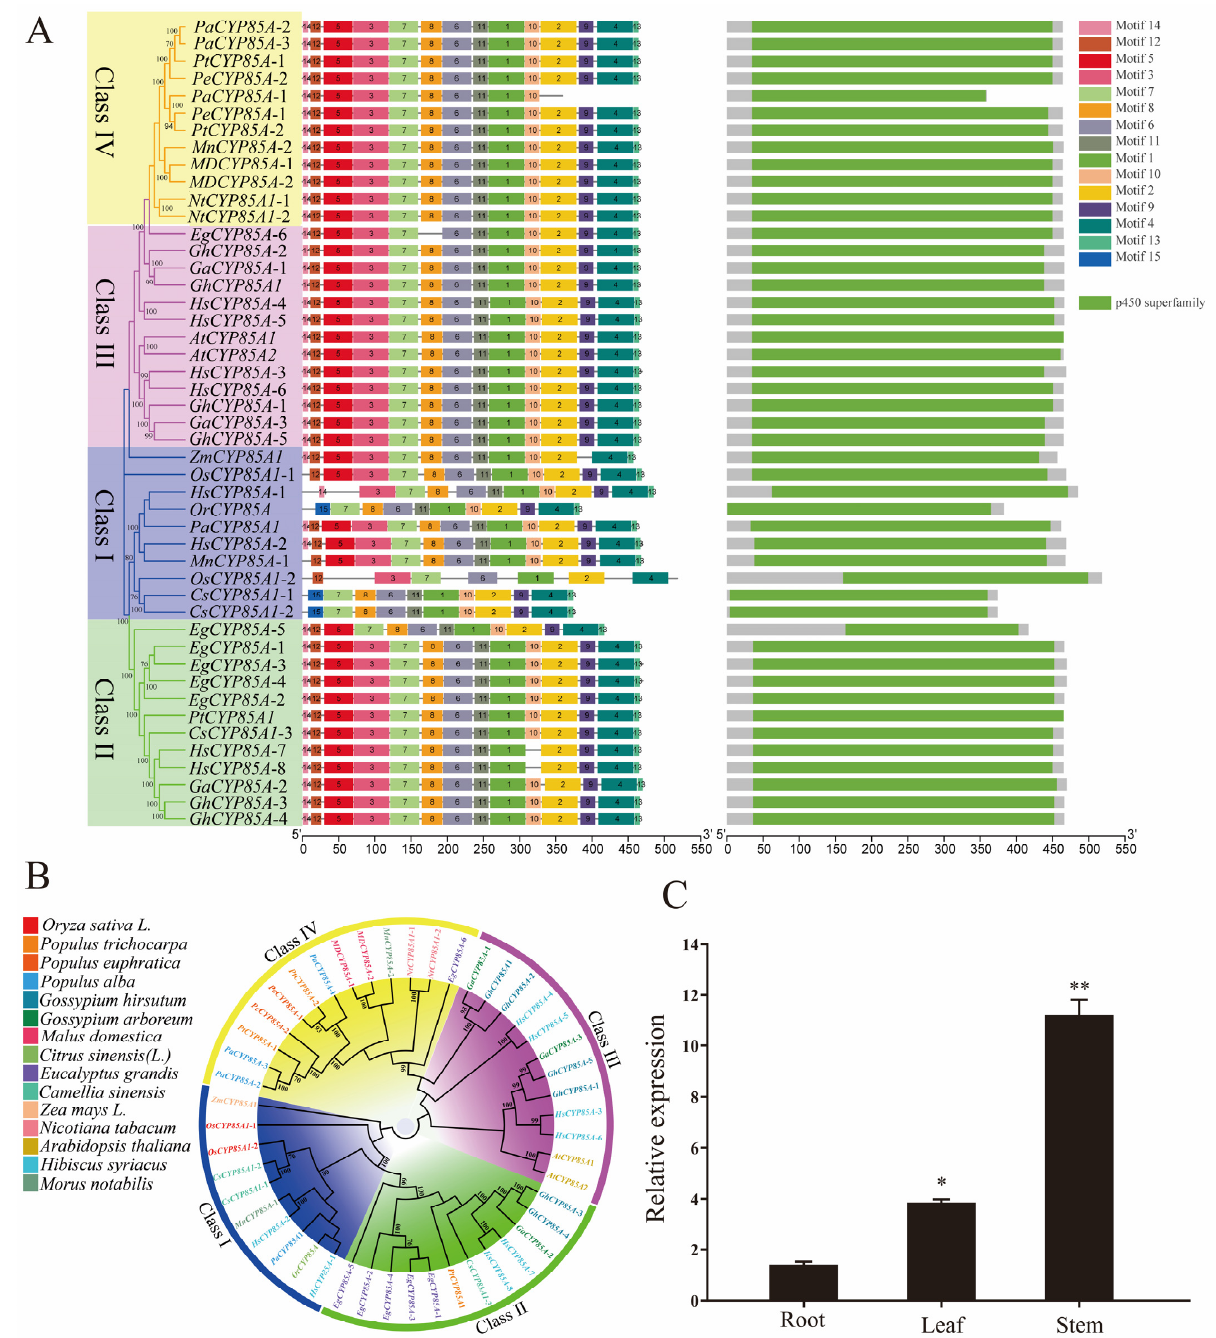
Figure 1. Sequence analysis of CYP85As proteins and expression patterns of OsCYP85A1 in different plant parts. ( A ) OsCYP85A protein has the typical functional domains of a conserved cytochrome P450 monooxygenase. ( B ) Phylogenetic relationships of OsCYP85A with CYP85As from P. euphratica (Pe), P. trichocarpa (Pt), A. thaliana (At), G. hirsutum (Gh), Zea mays (Zm), Oryza sativa (Os), Malus domestica (MD), Camellia sinensis (Cs), Gossypium arboretum (Ga), Nicotiana tabacum (Nt), Citrus sinensis (CS), Eucalyptus grandis (Eg), Hibiscus syriacus (Hs), and Morus notabilis (Mn). The scale bar represents 0.05 substitutions per site. ( C ) Expression of OsCYP85A1 in different organs of P. tomentosa . Error bars represent ± SD from three biological repeats. * Significant at p < 0.05 level and ** significant at p < 0.01 level according to Student’s t